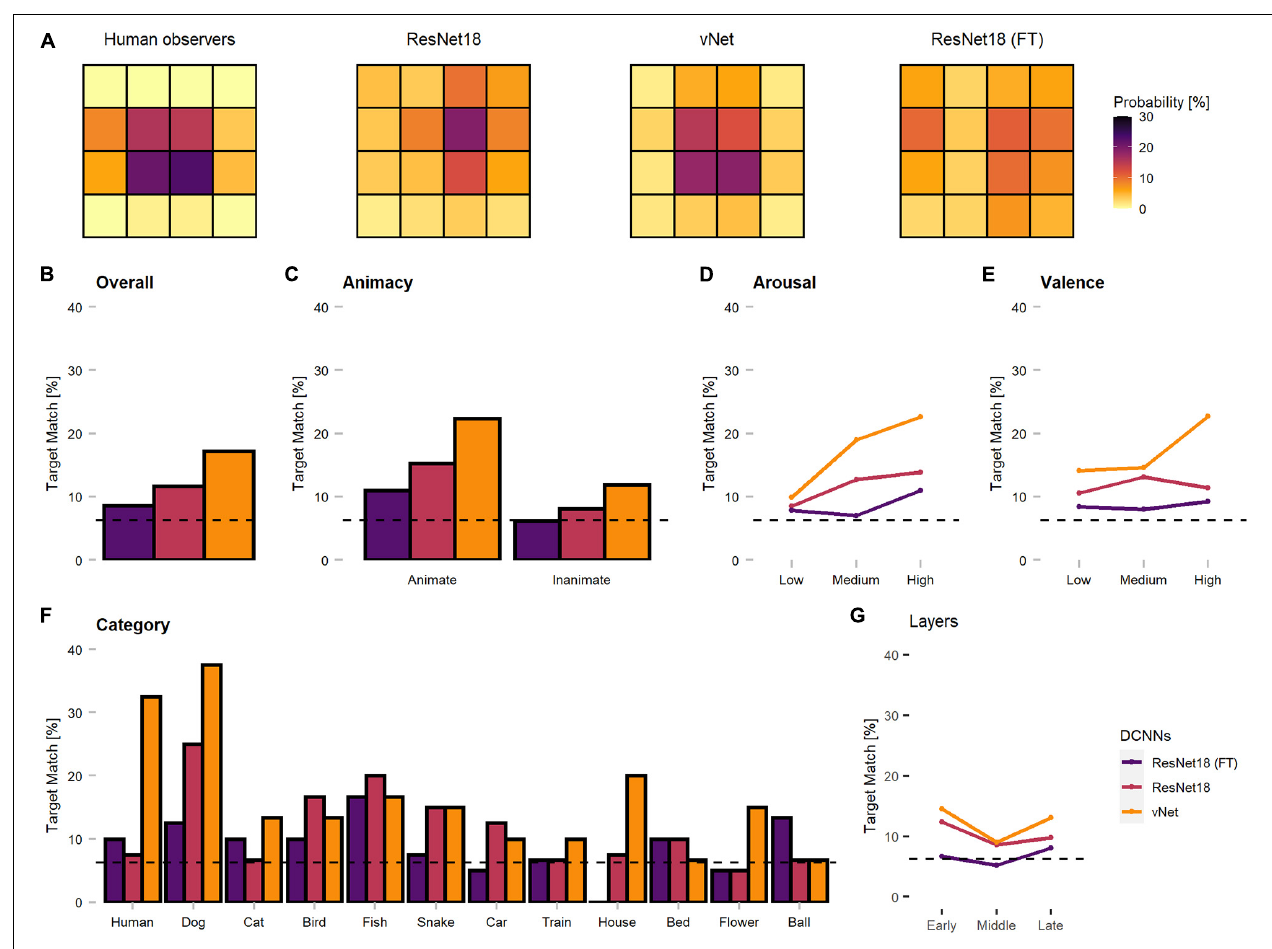
FIGURE 7 | Corrected spatial priorities during feedforward object recognition in human observers and DCNNs’ late layers. As the smallest resolution of output sizes allowed this resolution, all fixations and maxima were assigned to respective target blocks accordingly. (A) The target block percentages implied more similar spatial priorities between human observers and vNet, as mostly center blocks were targeted. In contrast, both ResNet18 models focused more on marginal target blocks. (B) Match between human and DCNN late layer target blocks across different grouping variables. vNet matched human target blocks more frequently. (C–E) DCNNs had a higher agreement on images of animate objects, with higher arousal ratings, and higher valence ratings. (F) vNet obtained especially high agreement on specific categories such as human and dog , while fine-tuned ResNet18 seemed to systematically choose different target block in house images. (G) Surprisingly, GradCAM maxima matched most frequently with human fixations in early, decreased in middle, and increased again in late layers. The dotted line represents chance level at